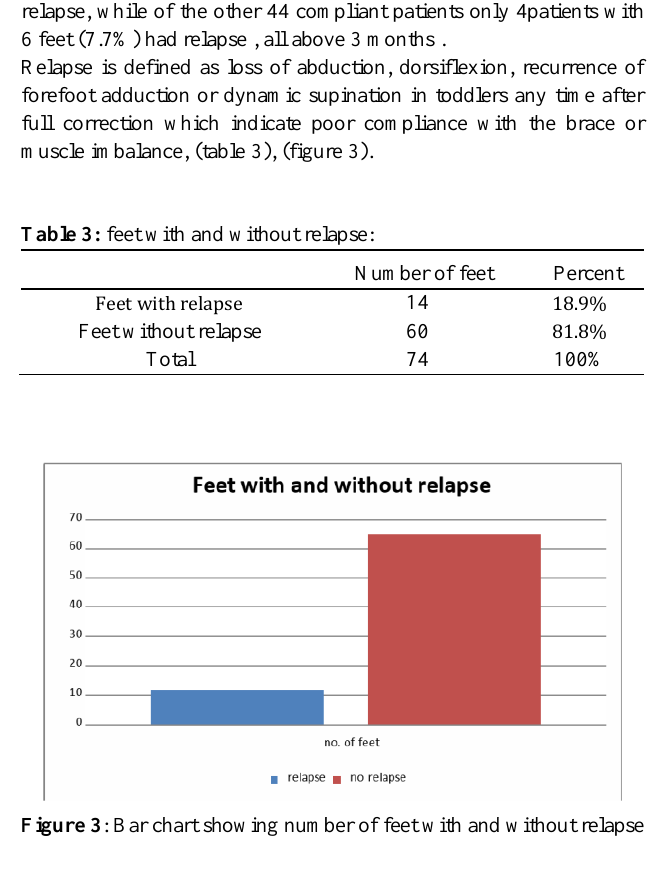
Figure 2 : Bar chart showing number of feet with and without cast falling Relapse Total of 10 patients with 14 feet (18.9%) had relapse , out of 6 noncompliant patients with 9 feet 5 patients with 6 feet (75%) had